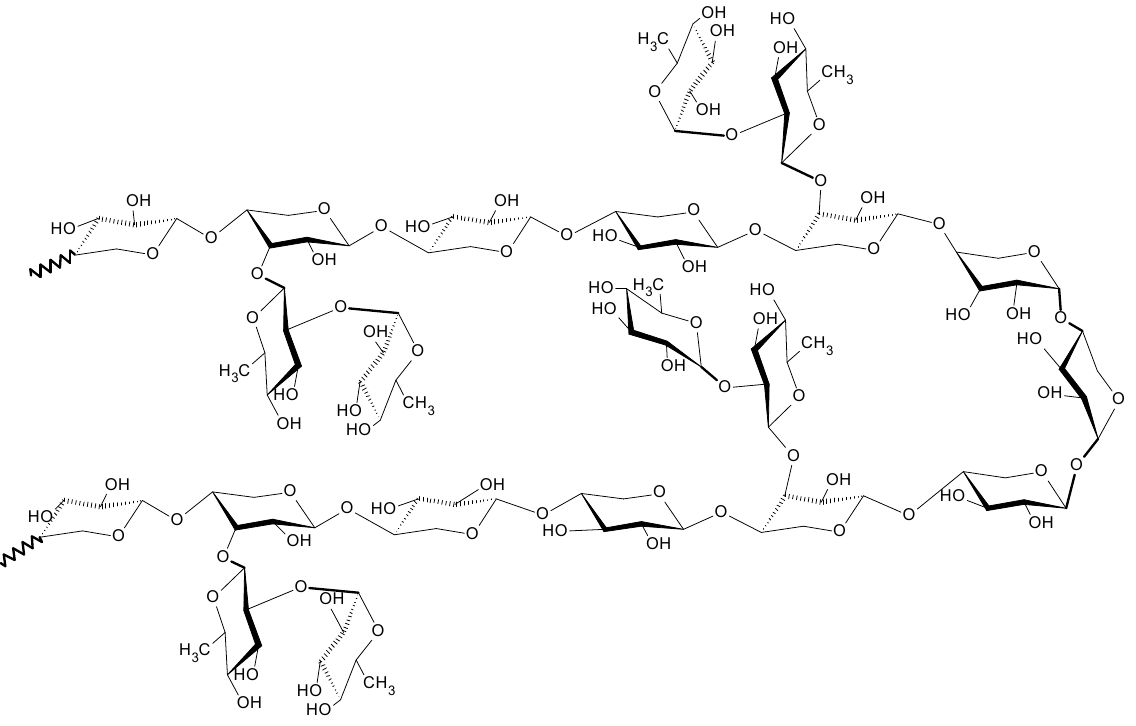
Figure 3. Structure of rhamnoxylan based on MALDI ‐ ToF mass spectral analysis.